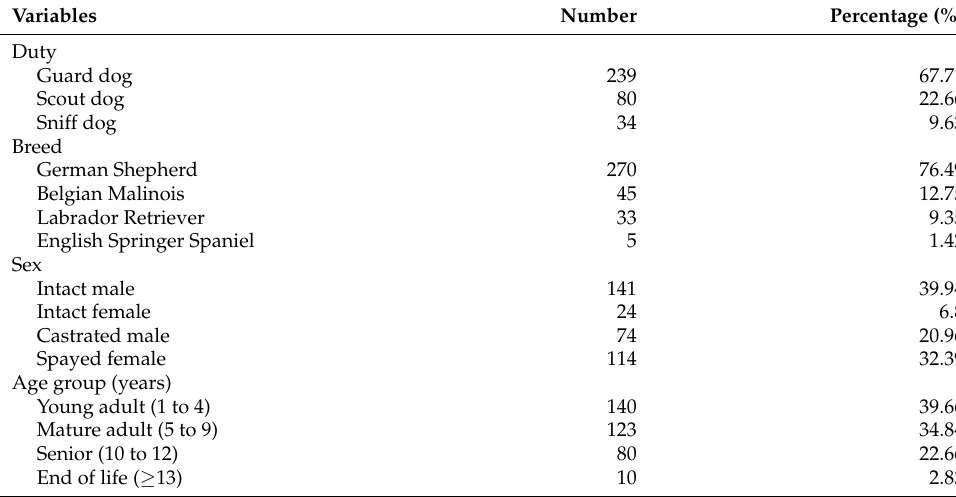
Table 1. Demographic summary of MWDs in this